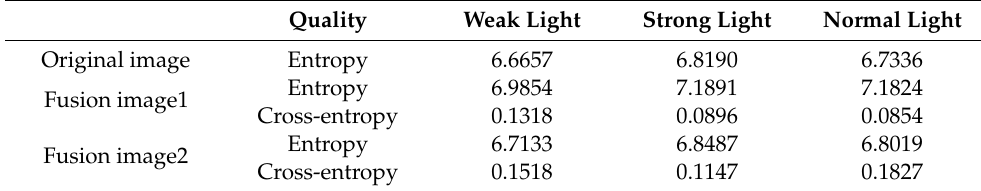
Figure 8. Image fusion results under different lighting conditions. Table 2. Entropy and cross-entropy of source image and fused images.